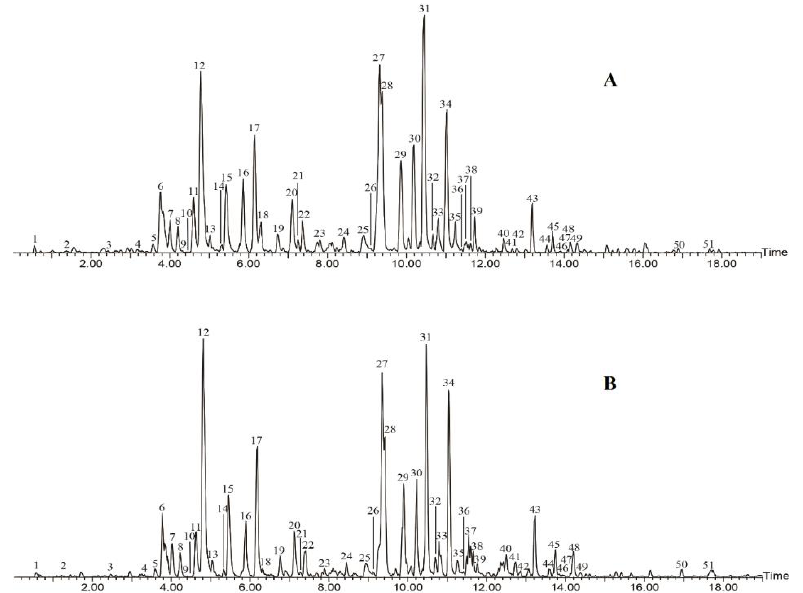
Figure 3. Total ion chromatograms in positive ( A ) and negative ( B ) modes of the extract ME obtained from AMF.